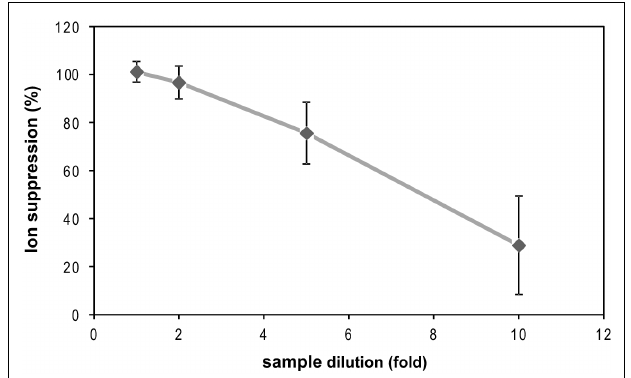
FIGUREA1 | Sample dilution led to decreased ion suppression. Illuminated Chlamydomonas reinhardtii CC-1690 suspension was quenched, harvested, and extracted as in Figure 1. Four different dilutions of the extract (diluted with water) were then spiked with a reference standard mix and compared to the standard mix on its own to assess the extent of ion suppression.The fivefold dilution was selected for experiments shown in Figures 1 and 4 ; Table 1 as for several metabolites the 10-fold dilution was below detection limit. Note that the average of ion suppression was 77% for the fivefold dilution in this experiment. For experiment shown in Figures 1 and 4 ; Table 1 , the average ion suppression for the fivefold dilution was < 13%.This improvement was vey likely achieved by using a quadrupole (FinningTSQ Quantum Ultra) with a larger ion transfer tube diameter.The plot shows the mean ion suppression for 24 metabolites, each measured with two technical replicates, ± SD.